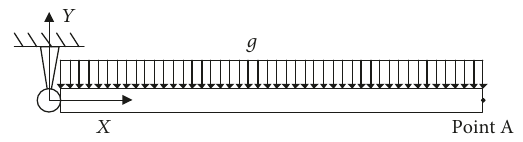
Figure 2: Planar rectangular pendulum with a change of the temperature fi